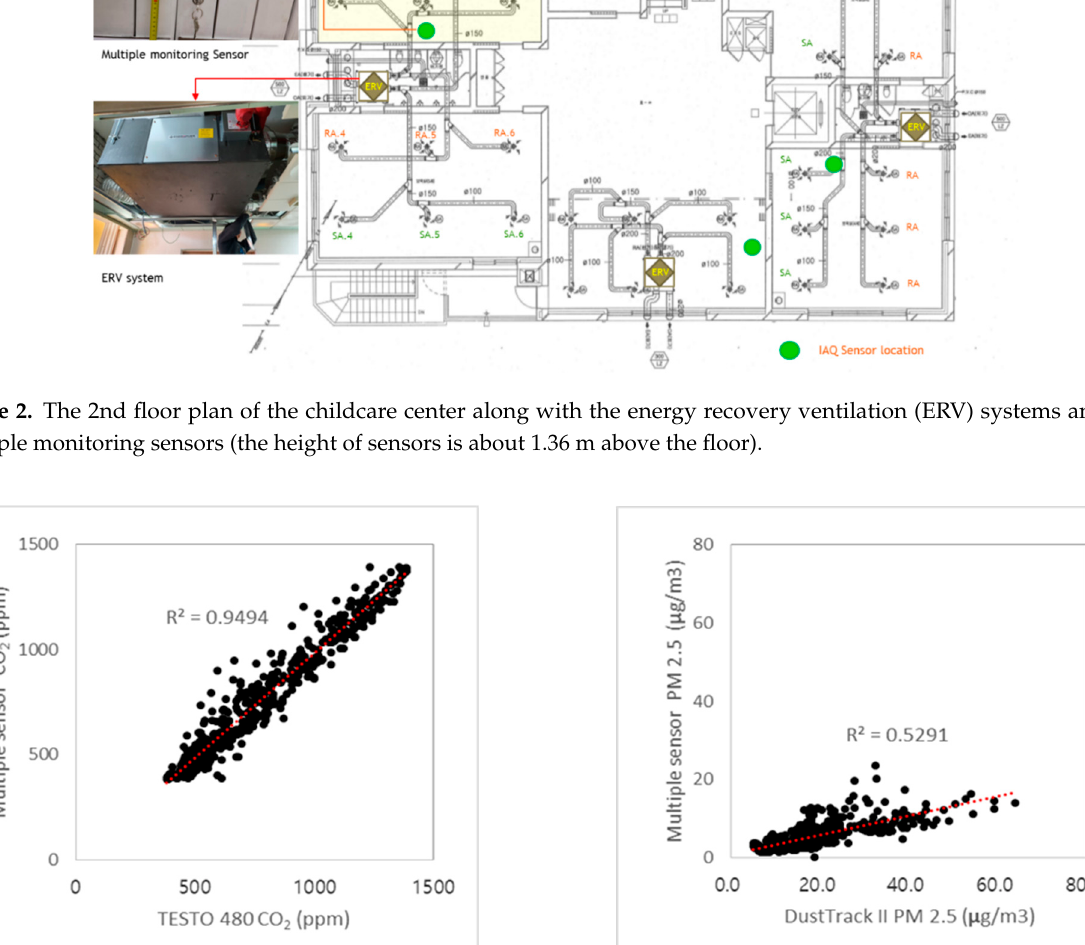
Figure 2. The 2nd floor plan of the childcare center along with the energy recovery ventilation (ERV) systems and the multiple monitoring sensors (the height of sensors is about 1.36 m above the floor). Table 1. Measurement range and accuracy of the multiple monitoring sensor.